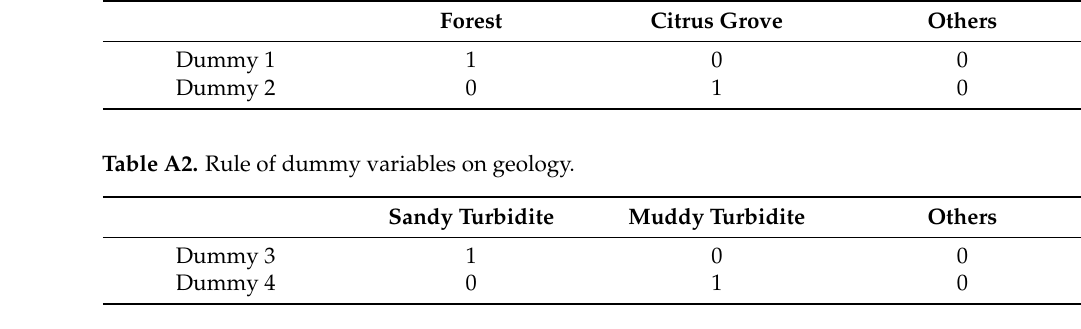
Table A3. Independent variables of models 1–10.